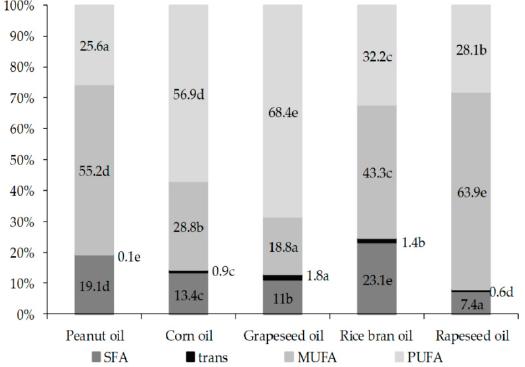
Figure 1. Fatty acid composition of the selected oils. Different small letters indicate statistically significant differences at the level p < 0.05 on columns for individual groups of fatty